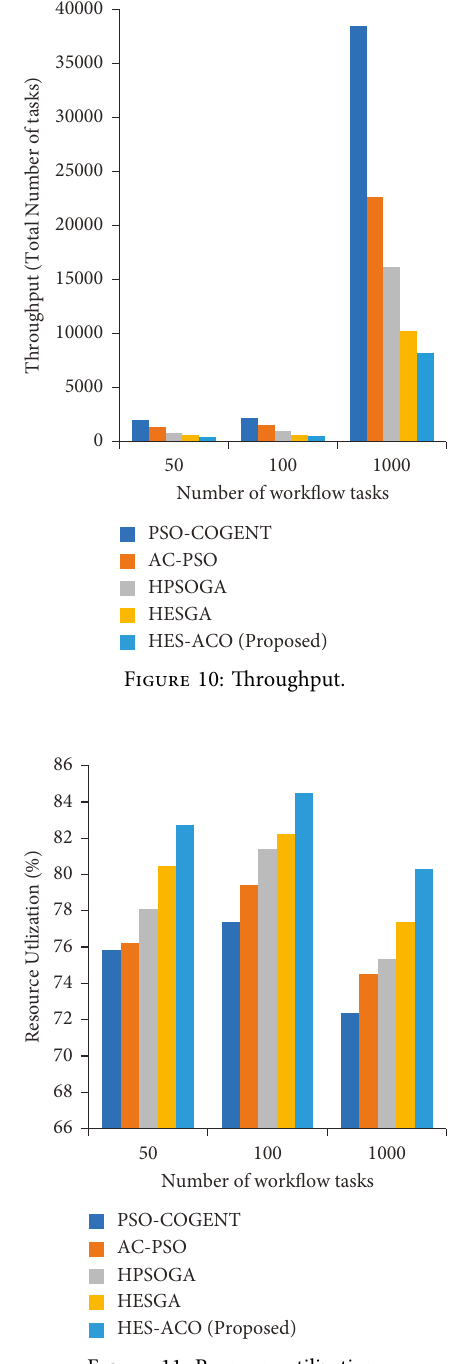
Figure 11: Resource